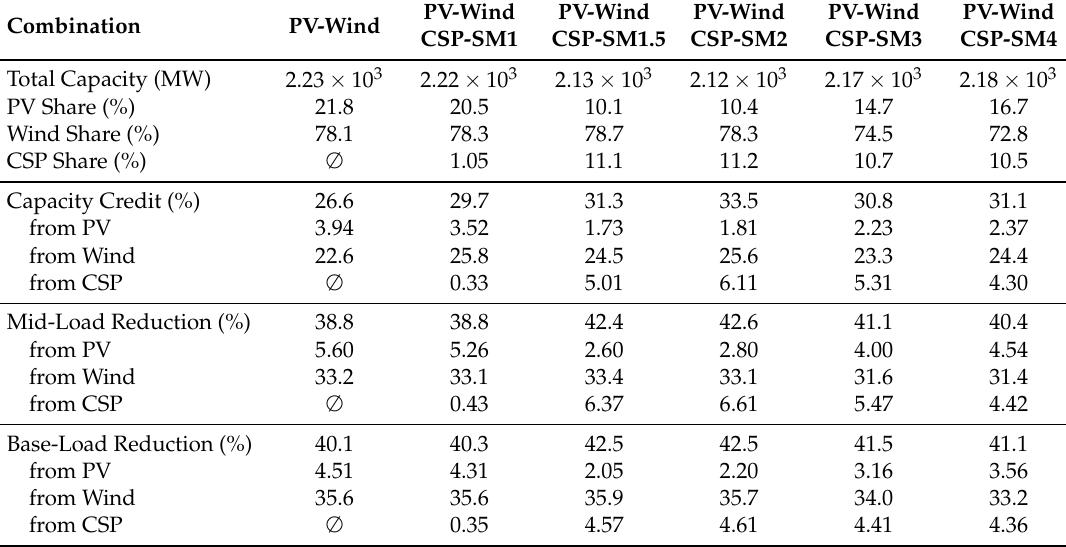
Table 9. Properties of the optimal mix at 20% penetration for the global strategy with the maximum-cost constraint and for different